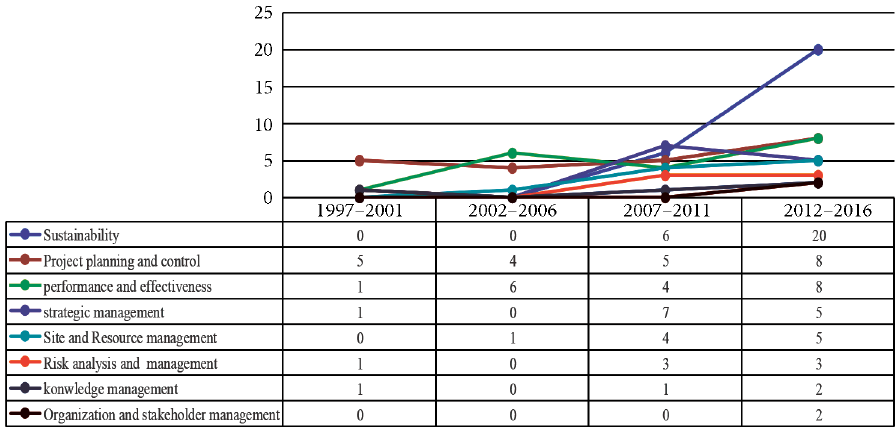
Figure 4. Change in topic coverage over time